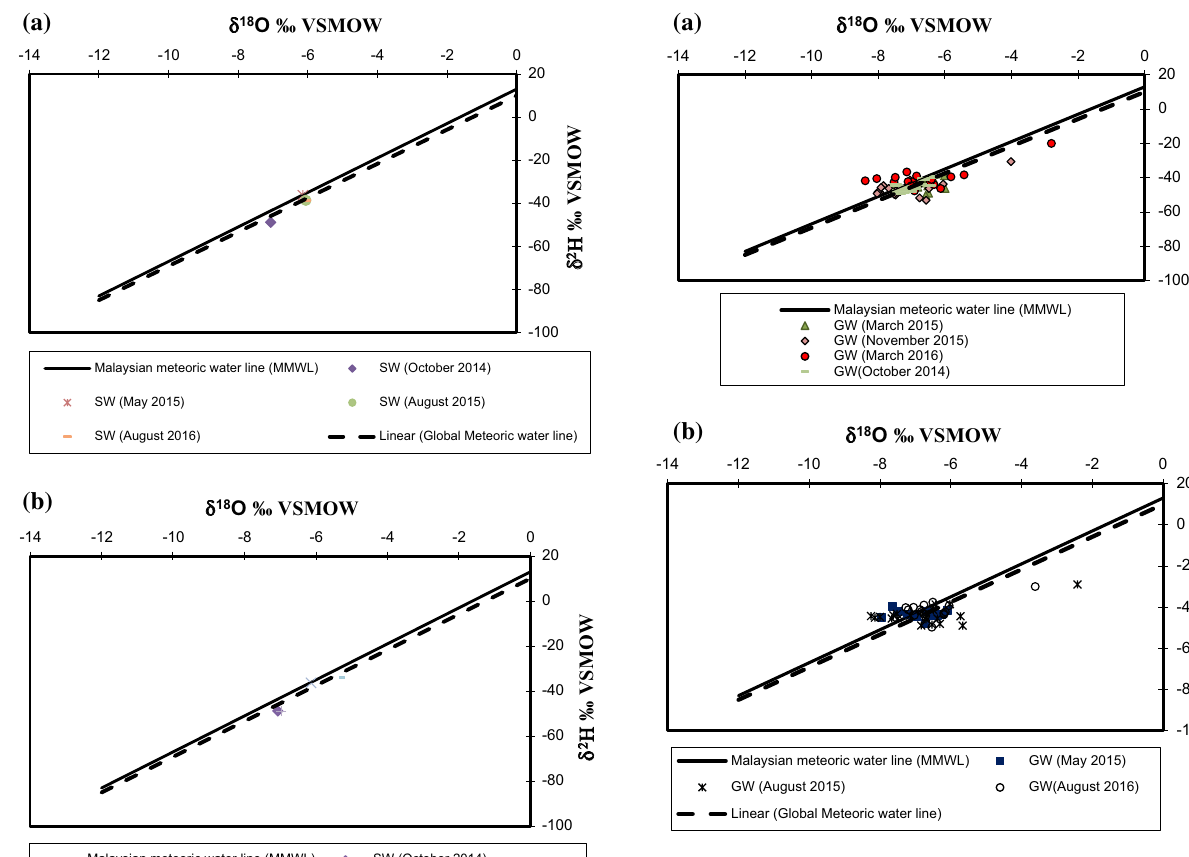
Fig. 6 Relationship between δ 2 H and δ 18 O for groundwater during